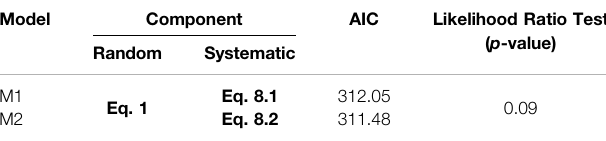
TABLE 2| Statisticalmodels examinedhere, theirAICvalueand the p -valueofthe log-likelihood